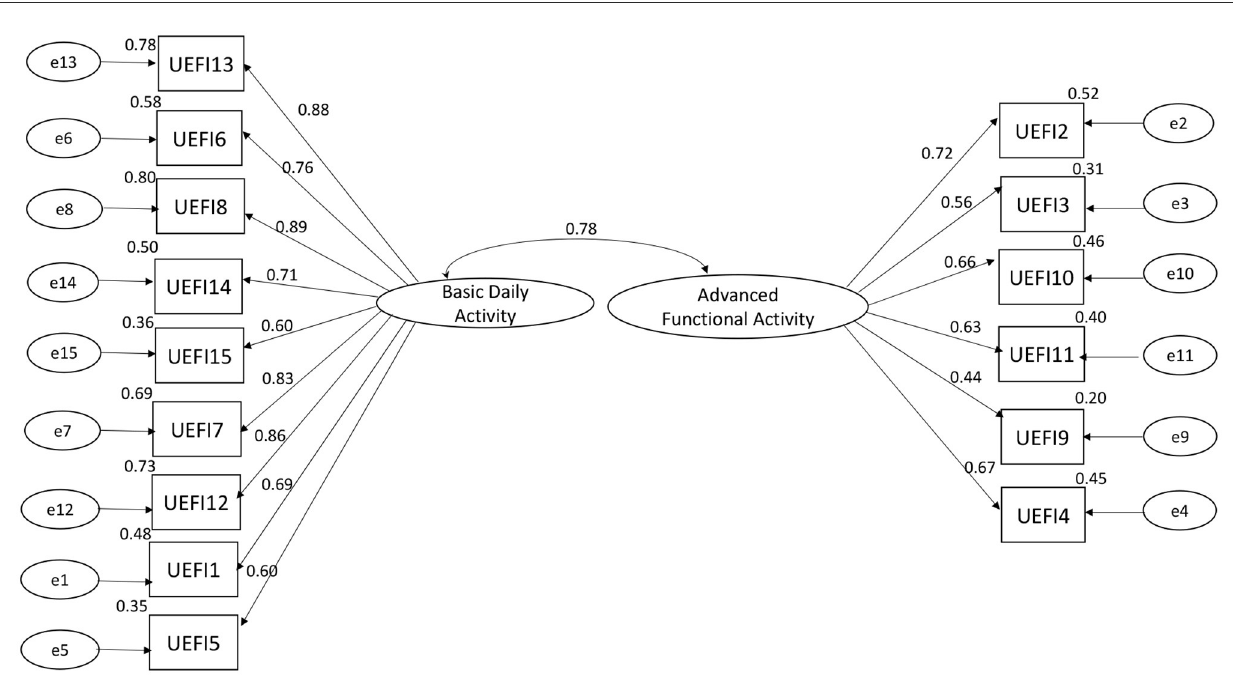
FIGURE2 Confirmatory factor analysis of C-UEFI: two factor model ( N 101). Rectangles represent the individual items in the Chinese version of the upper = extremity functional index. Circles represent measurement errors. Ellipses represent the latent factors of the scale. The data on the double curved line represent the correlation between the two latent factors of the questionnaire. The data on the straight line represent the standardized regression weight. The data beside the rectangle represent the squared multiple